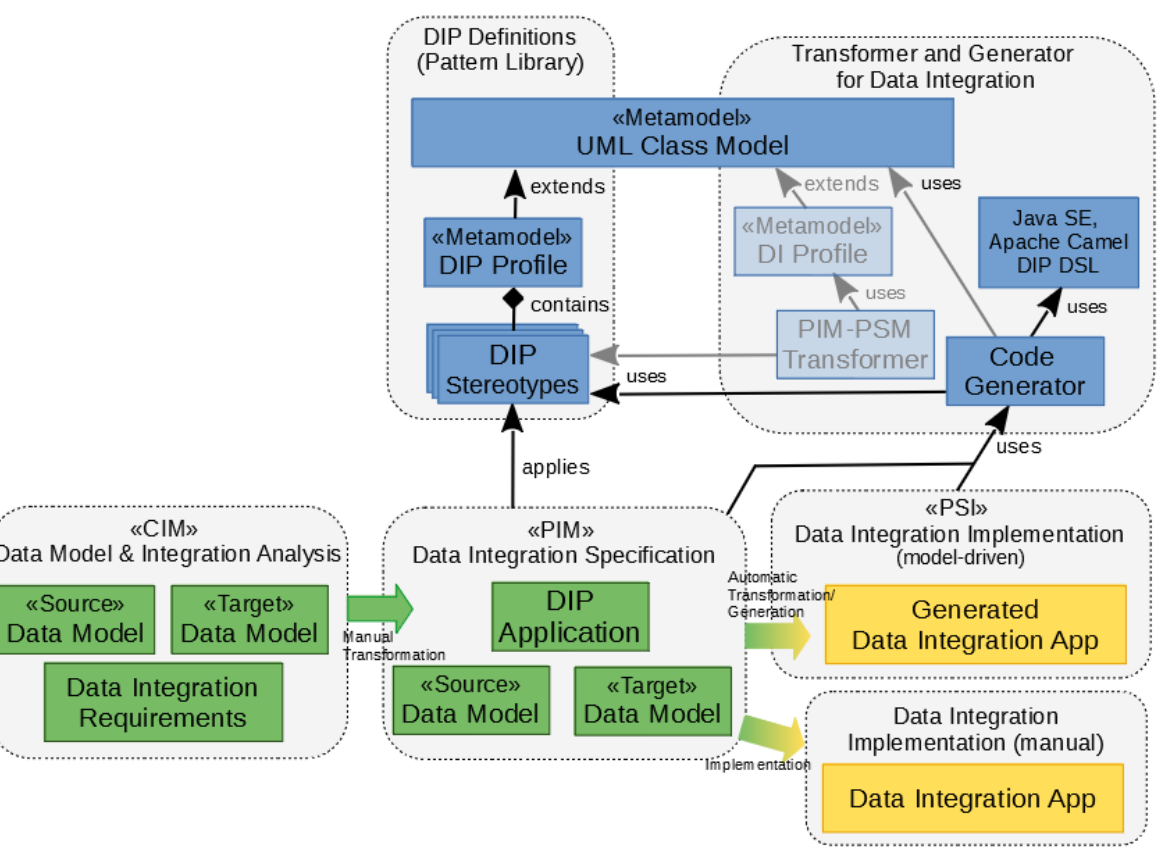
Figure 1. Model-driven and pattern-oriented methodology for data integration: overview.